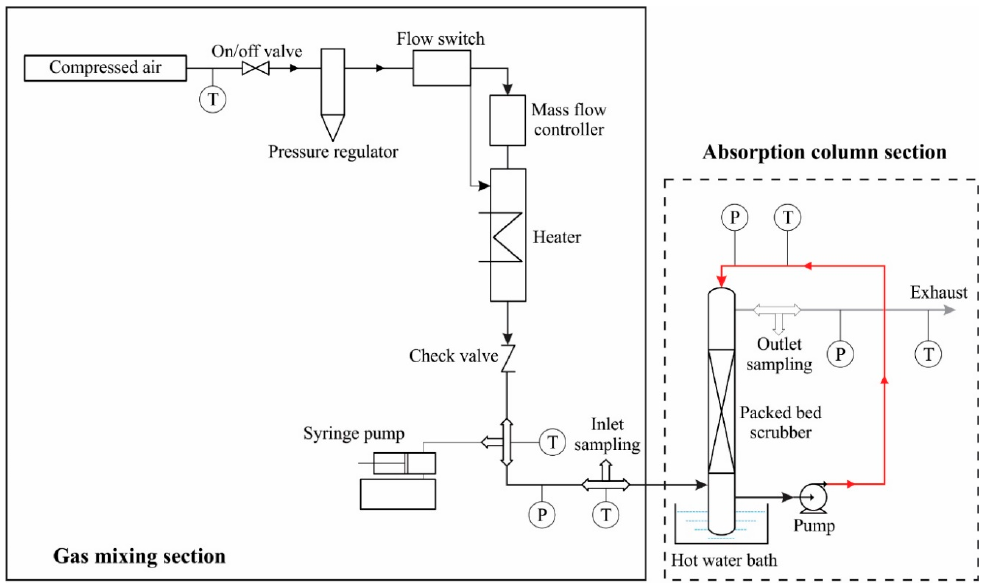
Figure 2. Schematic diagram of a bench-scale wet scrubbing set-up [27].